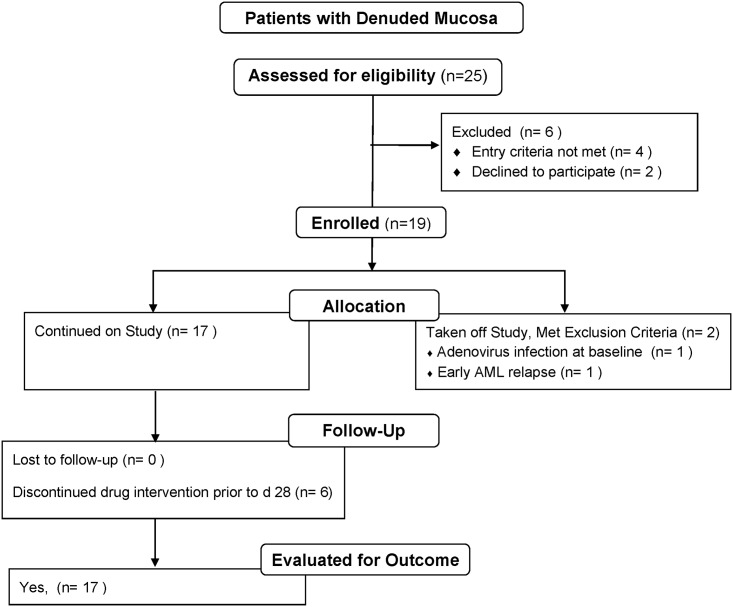
Flow chart of patients with denuded intestinal mucosa.